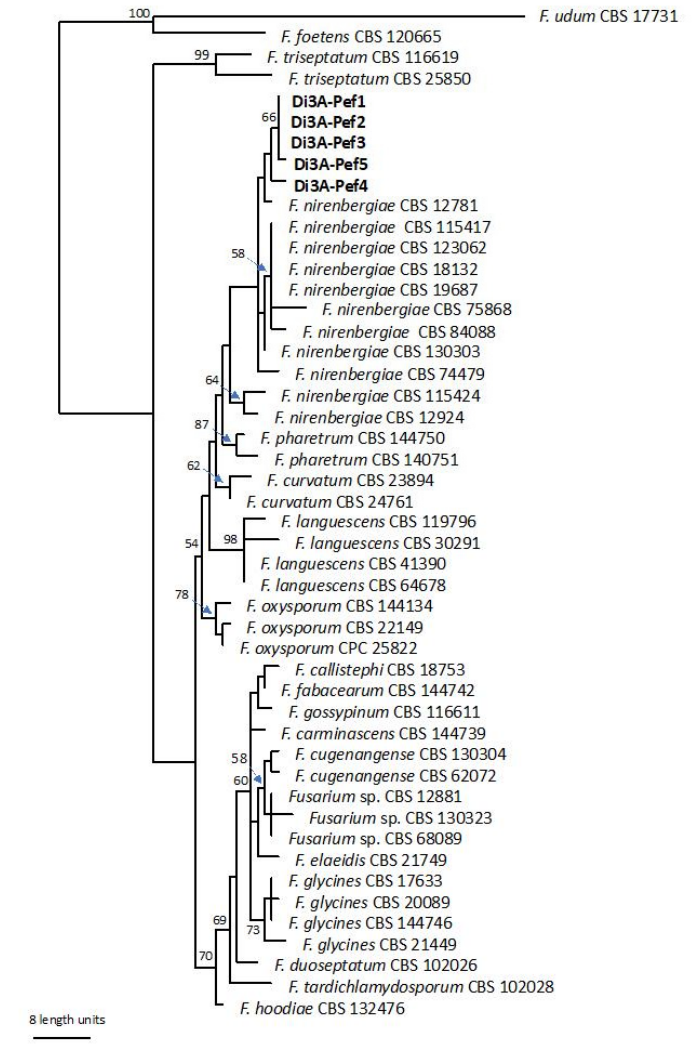
Figure 2. Single most parsimonious phylogenetic tree resulting from the MP analysis of combined EF1- α and rbp2 sequence data. The isolates in bold were sequenced in this study. The numbers represent MP bootstrap